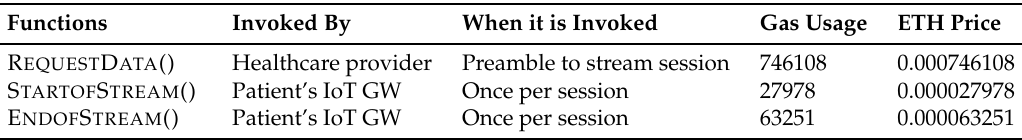
Table 1. Gas usage and transaction fees for executing functions in the remote health monitoring (RHM) smart